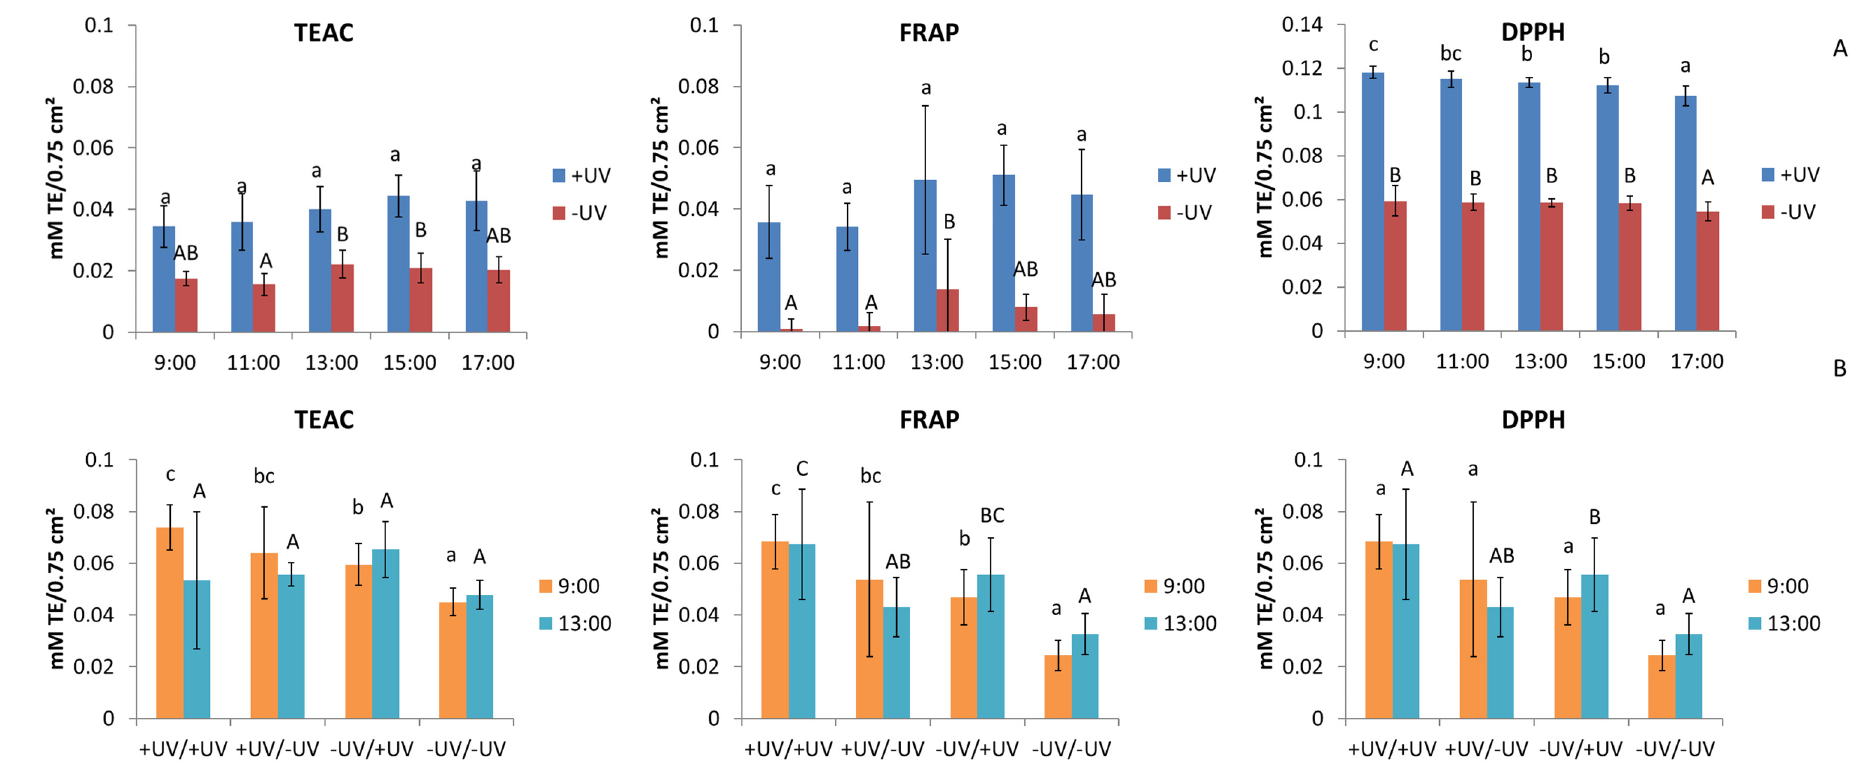
Figure 3. Antioxidant activity of okra plant extracts with TEAC, FRAP, or DPPH assay dependent on ( A ) the diurnal rhythm (Experiment 1—targeting diurnal rhythm) and ( B ) the UV conditions at transfer and harvest times of 9:00 and 13:00 with a 7-day adaption period after the transfer (Experiment 2—targeting changes in diurnal rhythm due to transfer to the opposite UV condition). Different letters represent significant differences at p ≤ 0.05.